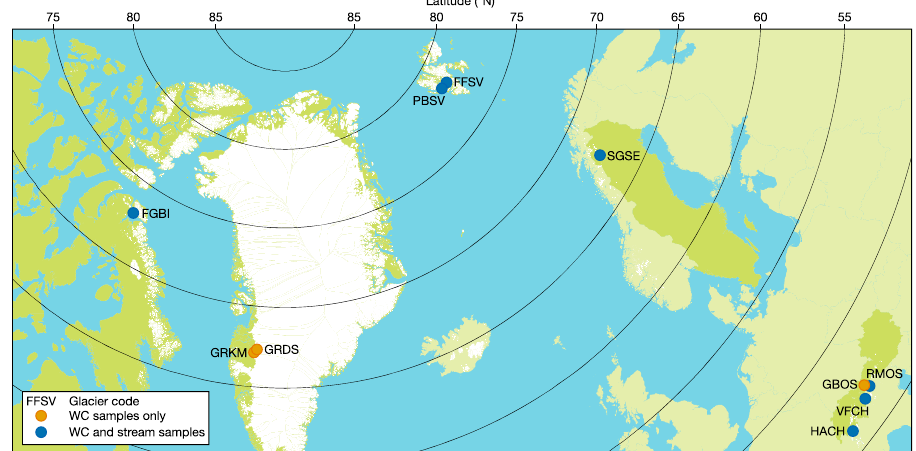
Fig. 2 Supraglacial sampling sites distributed around the Northern Hemisphere. Glacier codes are as follows: FFSV: Foxfonna; FGBI: Fountain Glacier; GBOS: Gaisbergferner; GRDS: Greenland Ice Sheet (S6); GRKM: Greenland Ice Sheet (Point 660); HACH: Haut Glacier d ’ Arolla; PBSV: Protektorbreen; RMOS: Rotmoosferner; SGSE: Storglaciären; and VFCH: Vadrec del Forno. Metadata for each site can be found in Supplementary